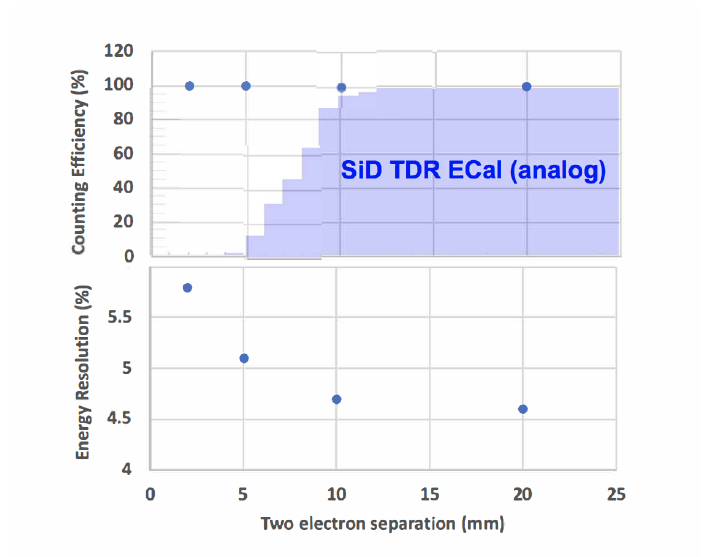
Figure 6. Efficiency for distinguishing two 10 GeV electron showers as a function of shower separation (upper curve) and the degradation of energy resolution as a function of separation due to overlap of cluster hits (lower curve) in the new SiD digital MAPS design based on a G EANT 4 simulation.